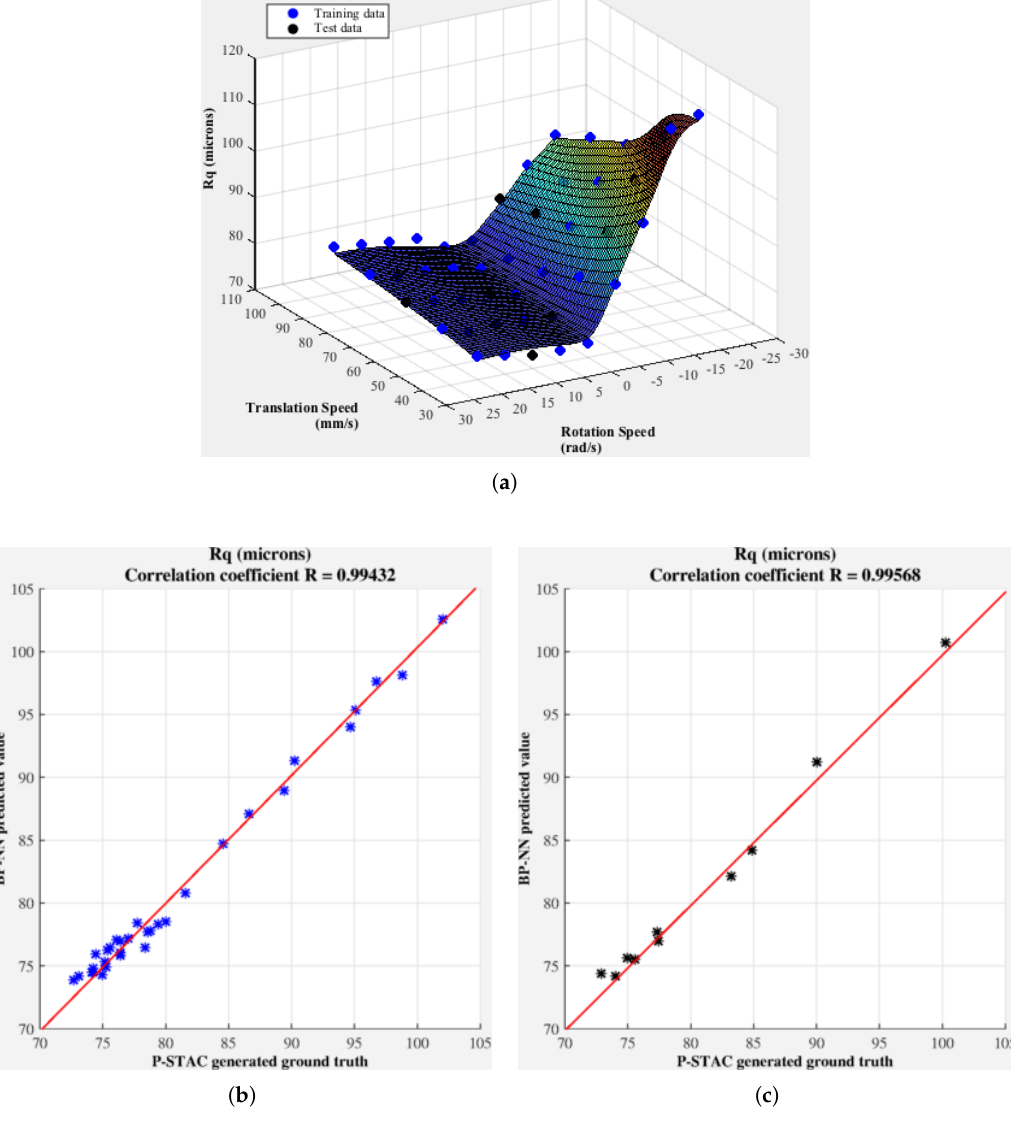
Figure 8. BP-NN predictions for the spreadability metric of spread layer roughness, R q for the case of spreading Ti-6Al-4V powder on an additively manufactured spreading substrate with S q = 79 µ m ( a ) Regressed surface ( b ) Training data ( c ) Test